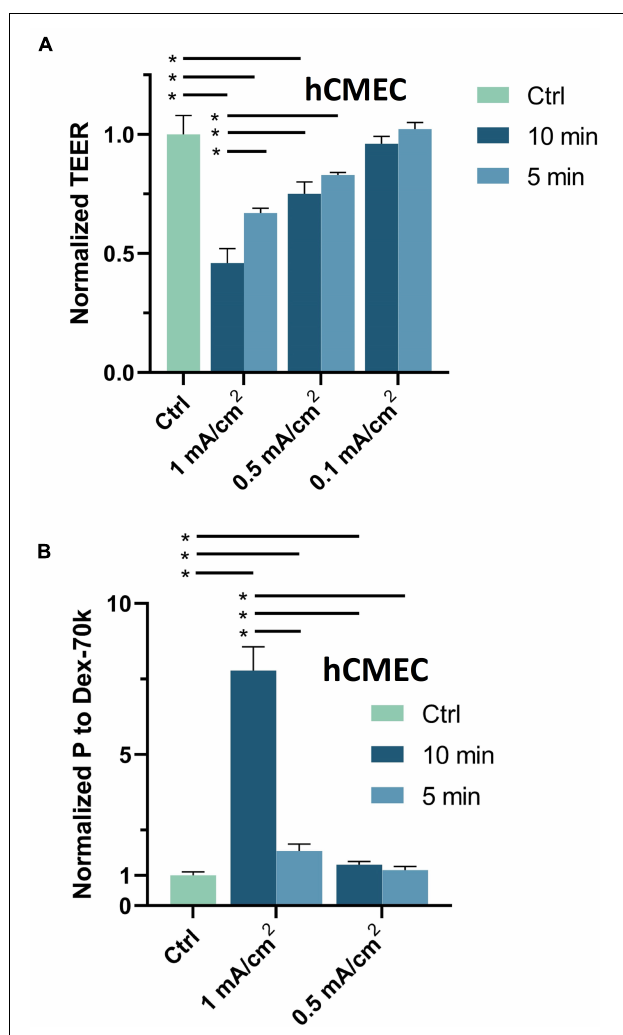
FIGURE 3 | Effects of DCS strength on in vitro BBB TEER and permeability. (A) Normalized TEER and (B) normalized permeability to Dex-70K under control and after 5 min or 10 min treatments with 0.1, 0.5, or 1 mA/cm 2 DCS. * p < 0.05. The in vitro BBB was formed by hCMEC